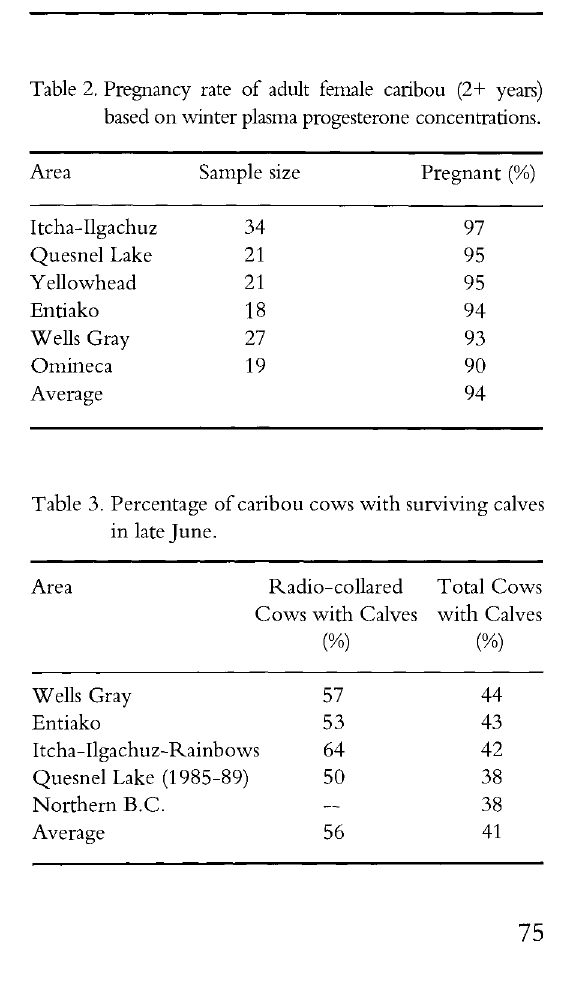
Table 2. Pregnancy rate of adult female caribou (2+ years) based on winter plasma progesterone concentrations.